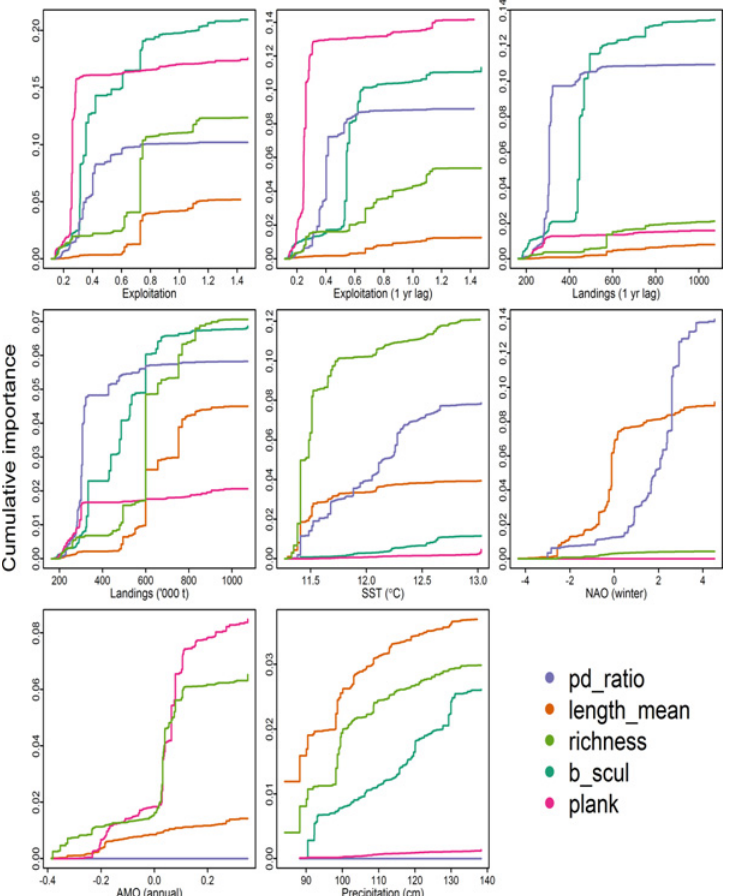
Fig 2. Cumulative shifts (in R 2 units) of ecological indicator value across the gradient of environmental and anthropogenic pressure variables. Each plot is scaled to the maximum cumulative response to allow for direct comparison of ecological indicator response to each pressure variable. Ecological indicator abbreviations are listed in Table 3.